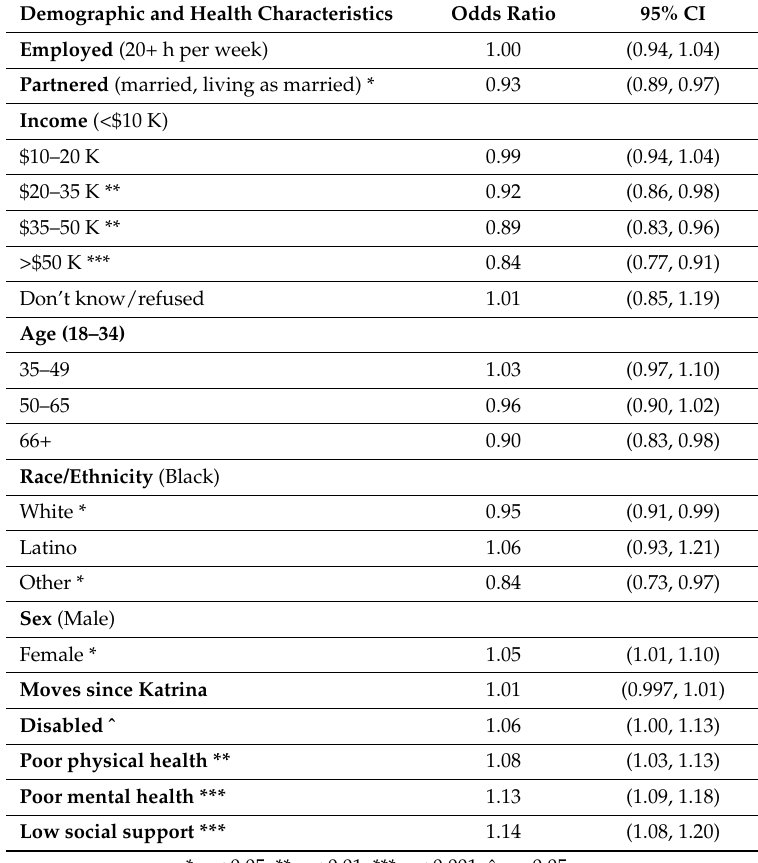
Table 4. Odds of reporting food insecurity by demographic and health characteristics of respondents over